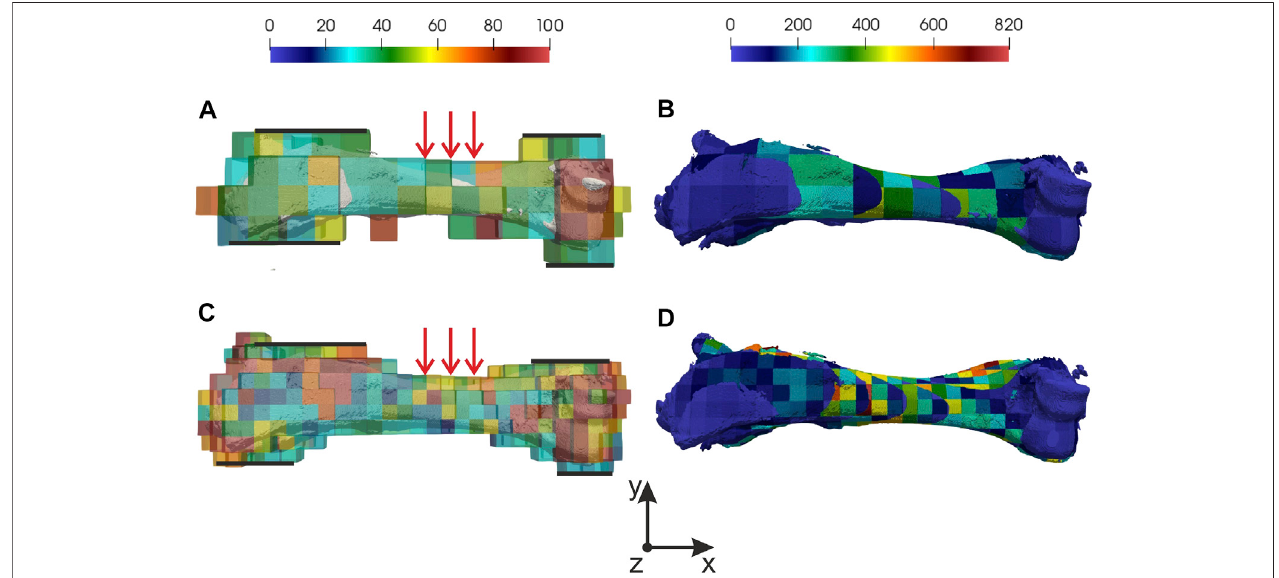
FIGURE2| DistributionofnormalizederrorandVonMisesstress: (A) normalizederrorfor10 mmmesh, (B) VonMisesstressfor10 mmmesh, (C) normalizederror for 5 mm mesh, (D) VonMises stressfor5 mm mesh. In (A,C) fi xed regionsmarkedbyblack lines and regionwheredisplacementswereapplied marked byred arrows.